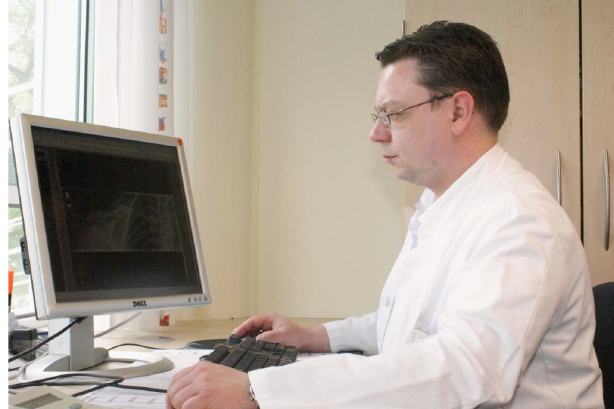
Figure 3. Second Opinion ©UKR, A.